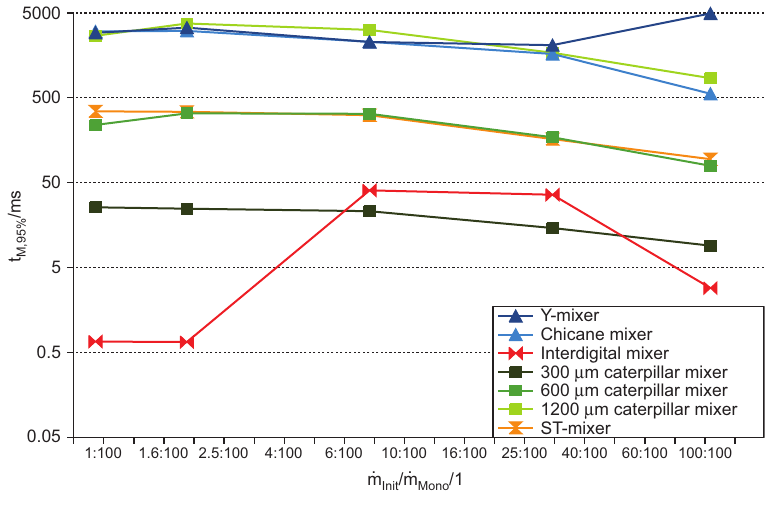
Figure 9 Mixing times to achieve 95 % mixing quality as a function of the ratio of initiator mass fl ow rate to monomer mass fl ow rate for all investigated